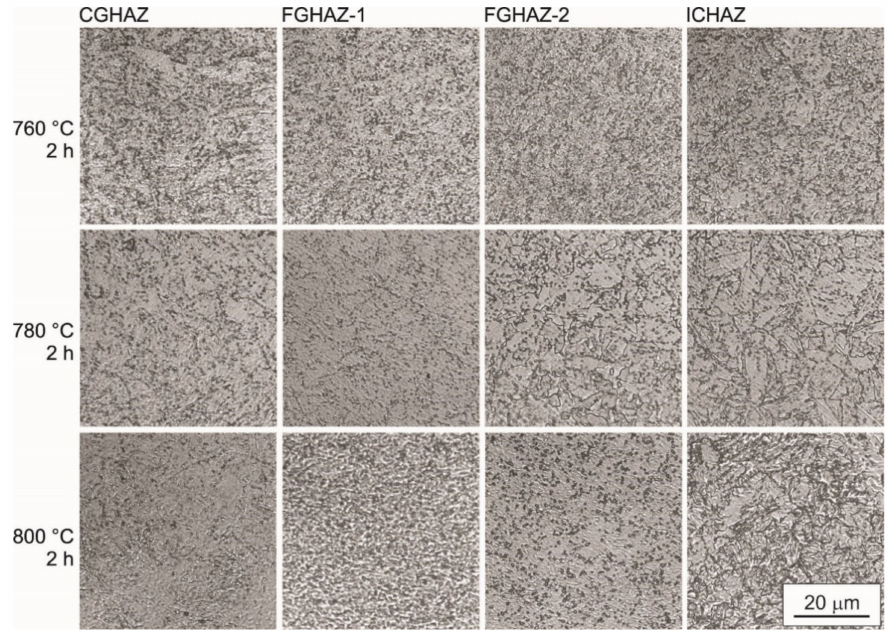
Figure 12. Microstructures after PWHT at 760–800 ◦ C for 1 h.